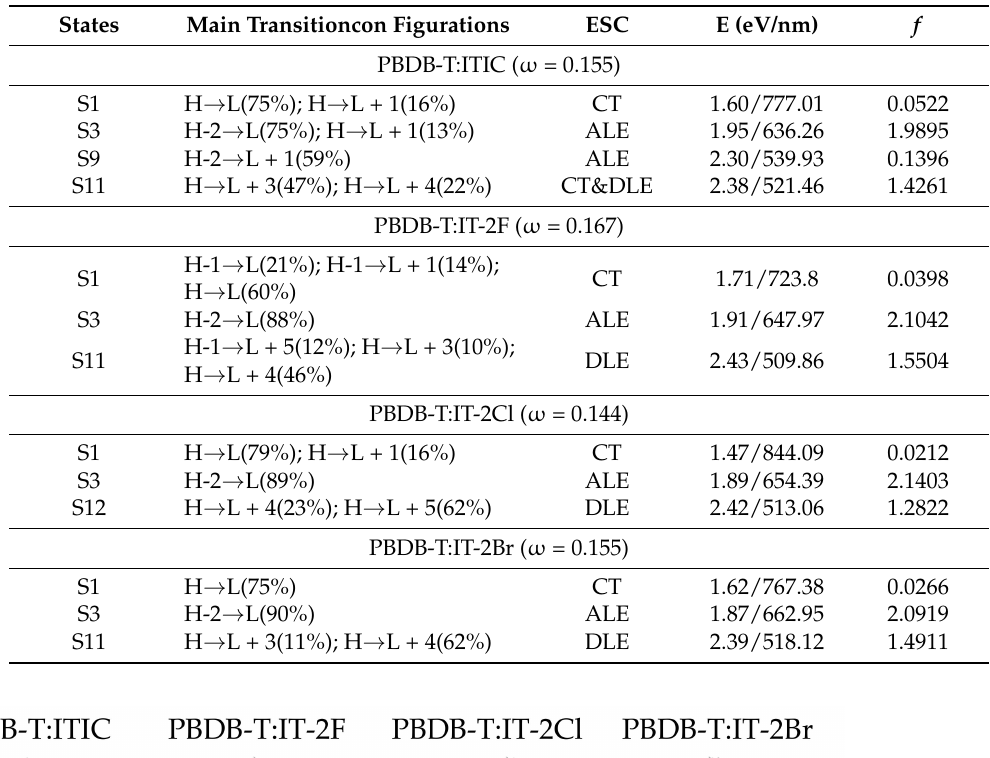
with higher energy of these complexes exhibit hybridization of CT and local excitation (see Table S4 in SM), which are favorable to charge carrier generation by hot ED processes [78]. Table 6. Electronic transition energies (in eV), corresponding oscillator strengths ( f ), excitation wave- lengths (in nm), excited states characters (ESC), and main transition configurations with coefficients larger than 10% for the selected excited states of PBDB-T:ITIC and PBDB-T:IT-2X (X = F, Cl, Br)